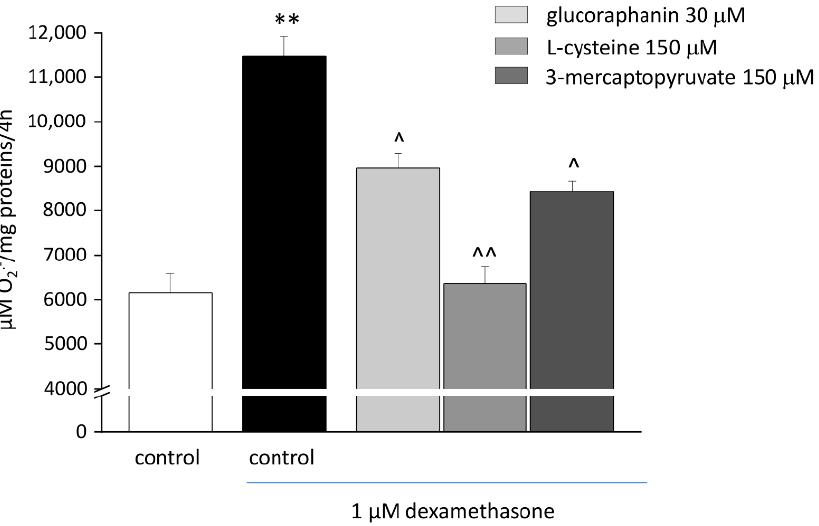
Figure 3. Catalase activity in C2C12 myotubes. C2C12 myotubes were treated for 48 h with 1 μM DEX, both alone and in the presence of 30 μM glucoraphanin, 150 μM L-cysteine, and 150 μM mercaptopyruvate. A fluorescence assay was used to quantify catalase activity. Values are expressed as mU/mg protein and calculated as the mean ± S.E.M. of 3 experiments. ** p < 0.01 versus control; ^ p < 0.05 and ^^ p < 0.01 versus DEX.